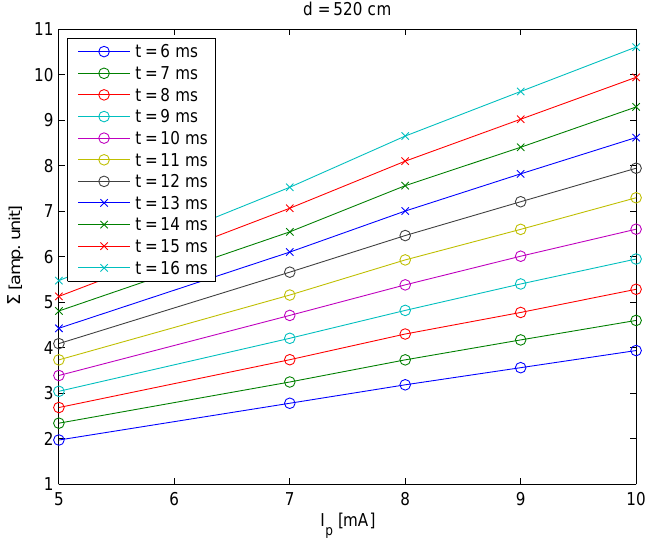
Figure 6. Values of (cid:6) obtained for a distance between the camera and the IRED of 520 cm, for different exposure times ( 6 , 7 , . . . , 16 ms) and for different IRED bias